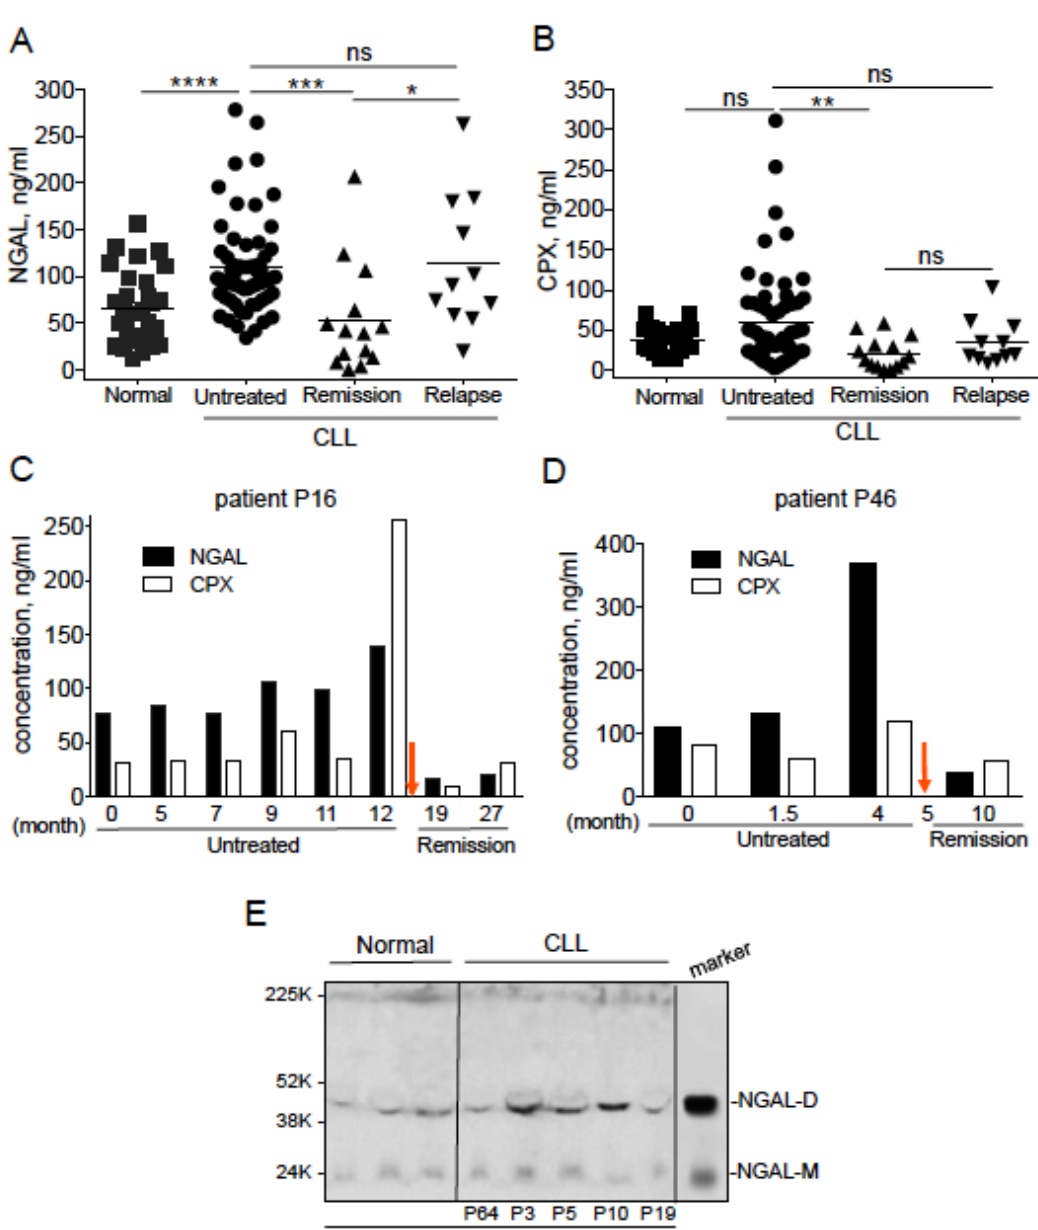
Figure 1. Serum concentrations of neutrophil gelatinase-associated lipocalin (NGAL) in healthy individuals and patients with CLL. ELISAs were performed on 30 normal individuals, 56 untreated CLL patients, 13 CLL patients in remission and 9 CLL relapsed patients. ( A ) NGAL (monomer and dimer), and ( B ) NGAL complexed (CPX) to matrix metalloproteinase-9 (proMMP-9) protein levels were determined. p values were calculated using a Mann–Whitney U -test; not significant (ns); * p < 0.05; ** p < 0.01; *** p < 0.001 and **** p < 0.0001. ( C , D ) Levels of NGAL and CPX in two CLL patients (P16 and P46) before treatment (FCR and BR, respectively) or at remission; the red arrow indicates the beginning of the treatment. ( E ) Representative Western blot of NGAL expression in sera of normal and CLL samples (remission P72; untreated P3, P5, P10 and P19); an acute myeloid leukemia (AML) cell lysate was used as a marker of NGAL dimer and monomer. The primary antibody used was anti-NGAL specific for the dimeric and monomeric forms (clone AF1757, goat IgG; R&D Systems). Data are expressed as the ratio (%) between dimer NGAL (NGAL-D) and monomer NGAL (NGAL-M) ×